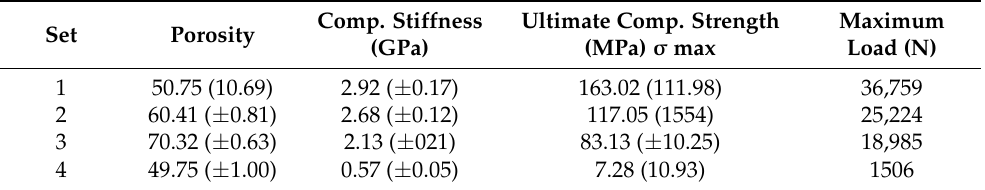
Table 1. Compressive stiffness and compressive strength of porous titanium parts. Reprinted with permission from ref. [78]. 2009, Elsevier